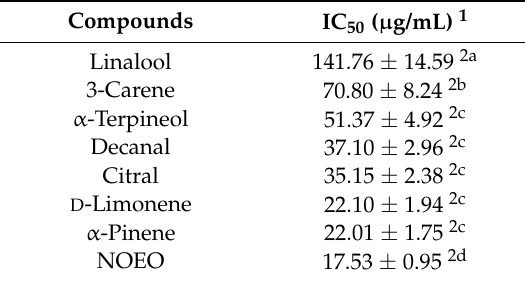
Table 2. IC 50 values of linalool, 3-carene, α -terpineol, decanal, citral, D -limonene, α -pinene and NOEO on proliferation of A549